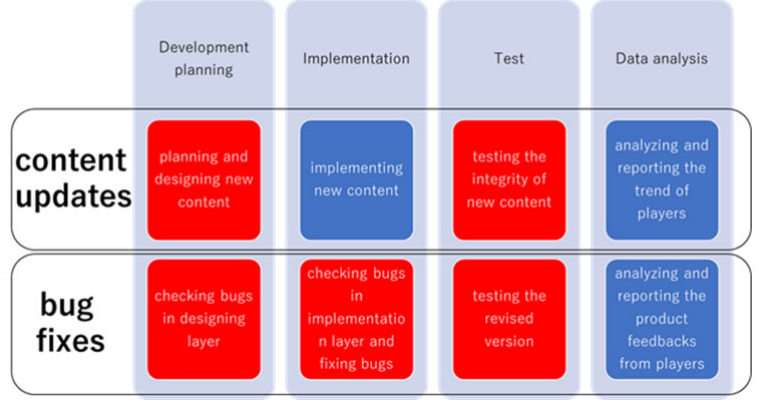
Figure 2. Main work processes of game development (after